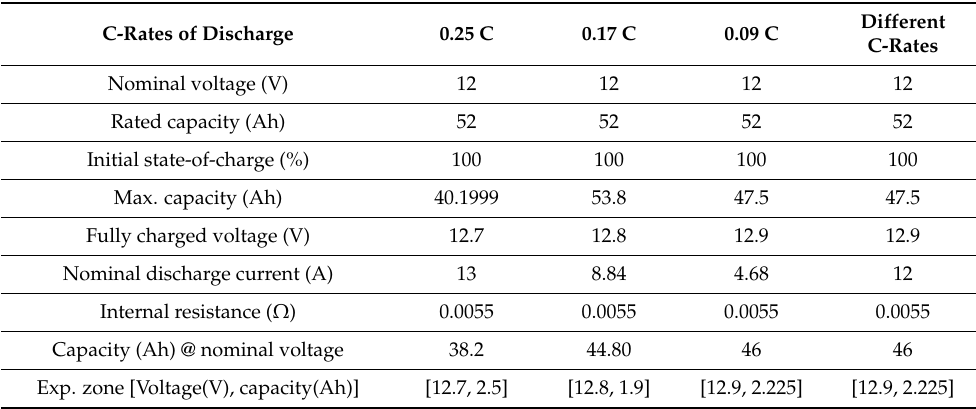
Table 2. Battery parameters: discharge at variable C-rate.